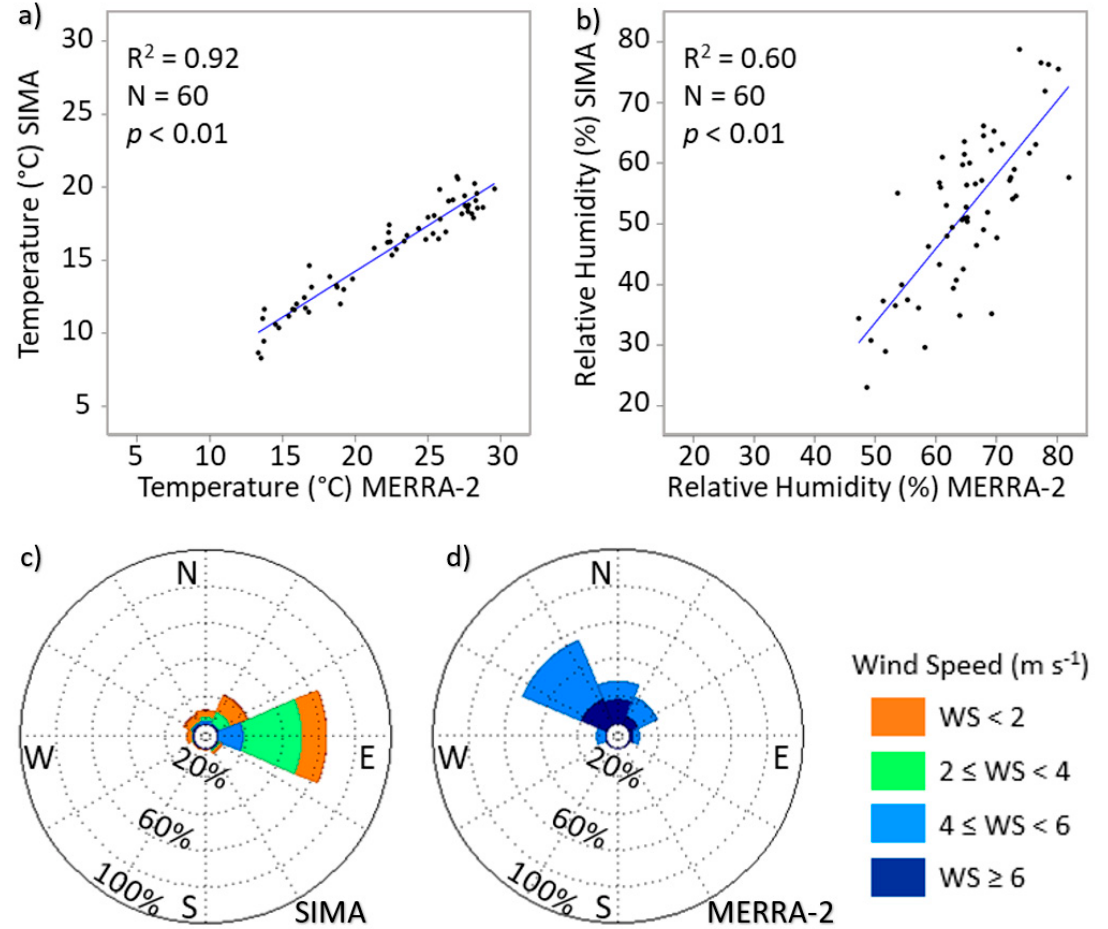
Figure 5. Comparison between the MERRA-2 meteorological data and monthly average ground-based data in the MMA from January 2010 to December 2014. ( a ) monthly temperature mean correlations; ( b ) monthly relative humidity mean correlations; ( c ) wind rose using wind components from SIMA; ( d ) wind rose using wind components from MERRA-2.